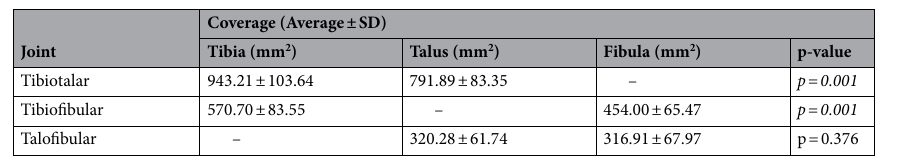
Table 1. Average surface area ± standard deviation (SD) reported for the coupled articular surfaces within the coverage region for the tibiotalar, tibiofibular and talofibular articulations.